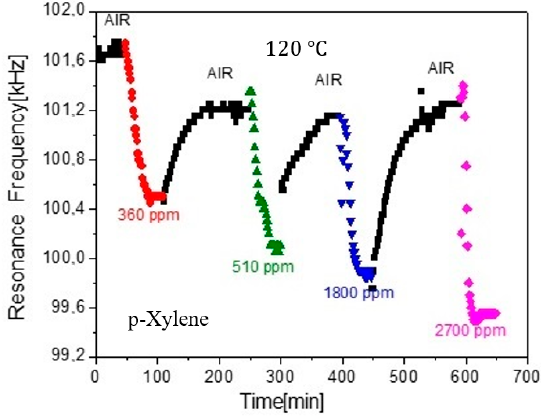
Figure 4. Data from PhD work [35], which corresponds to different p-Xylene concentrations on a Metglas/Faujasite (FAU) sensor.